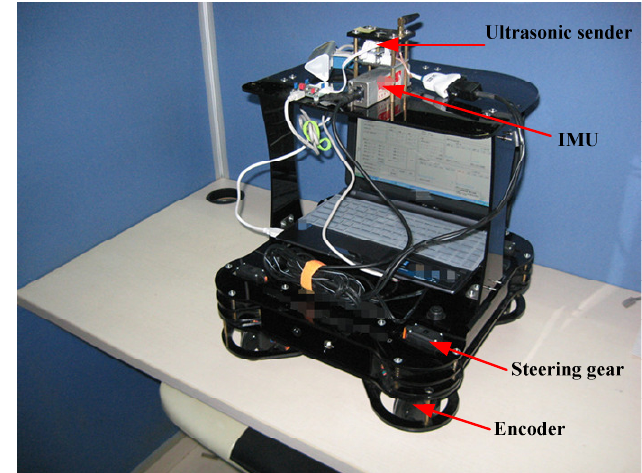
Figure 3. The prototype of the